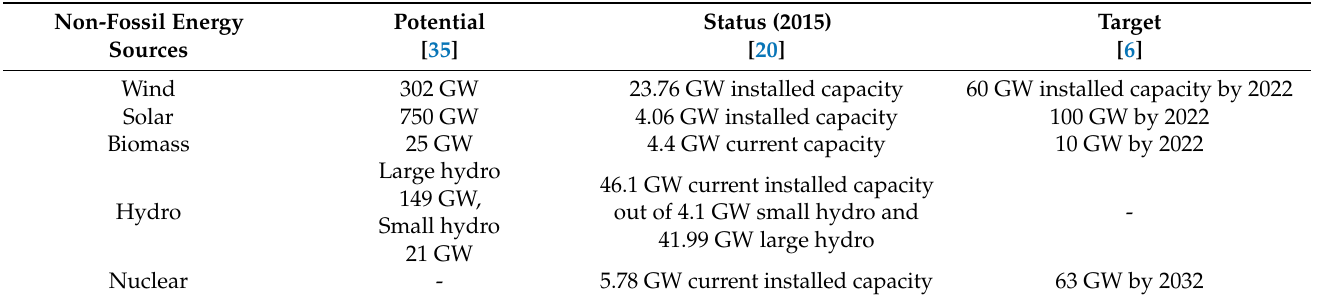
Table 2. Potential of power generation from non-fossil